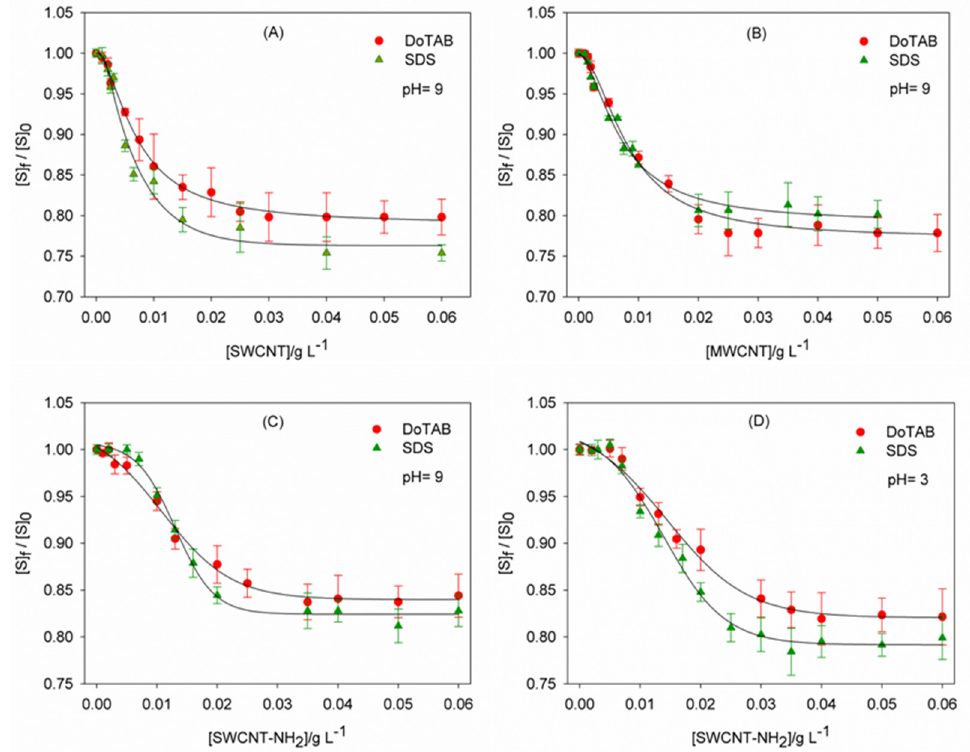
Figure 1. Plots of the relative free dodecyltrimethyl ammonium bromide (DoTAB) and sodium dodecyl sulfate (SDS) concentration versus the carbon nanotubes concentration in buffered aqueous solutions: ( A ) neutral single-walled carbon nanotubes (SWCNT); ( B ) neutral multi-walled carbon nanotubes (MWCNT); ( C ) neutral SWCNT-NH 2 (pH = 9); and ( D ) positively charged SWCNT-NH 2 (pH = 3).